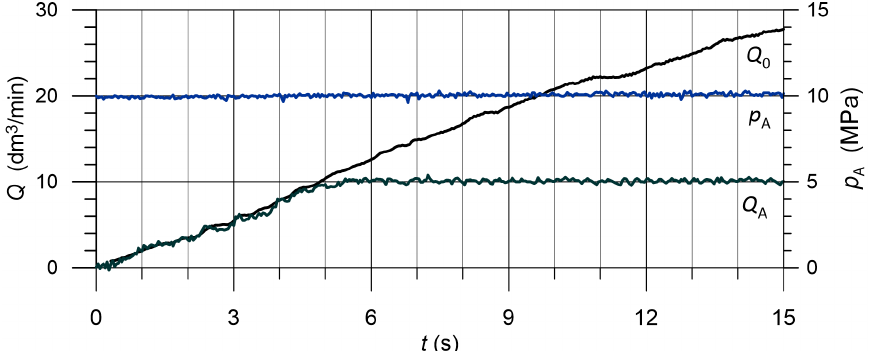
Figure 20. Experimental results of a variable flow rate test: Q 0 , Q A —flow rates, p A —supply line